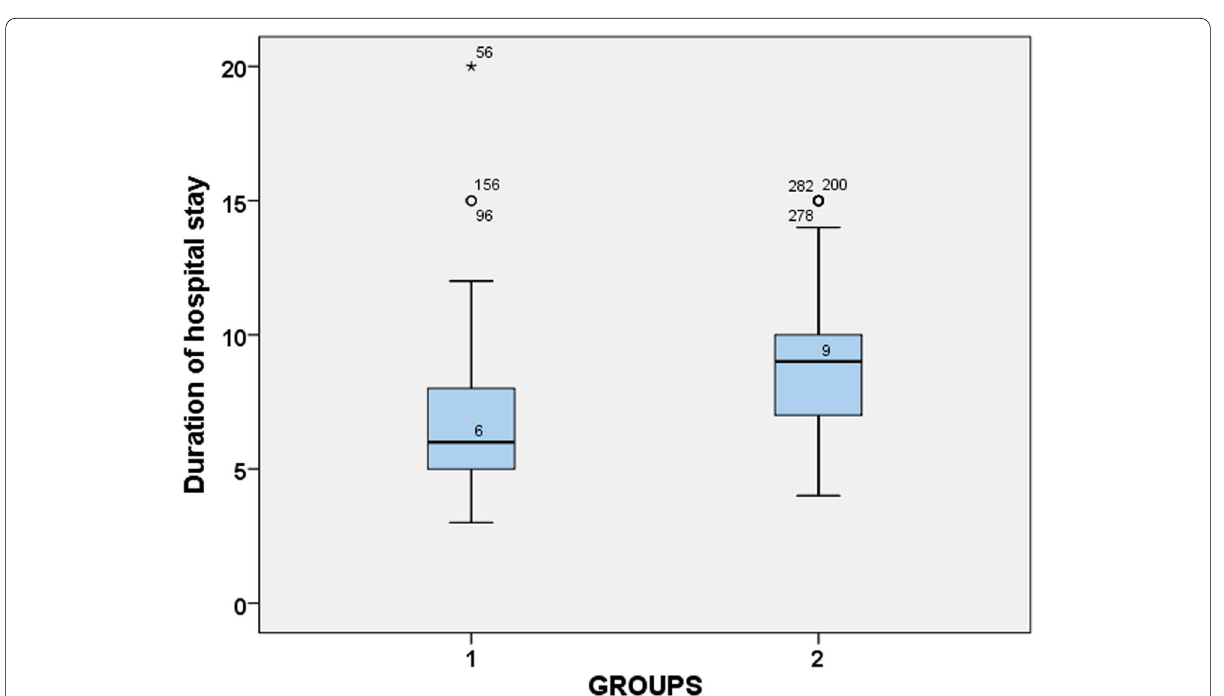
Fig. 5 Duration of hospital stay between both